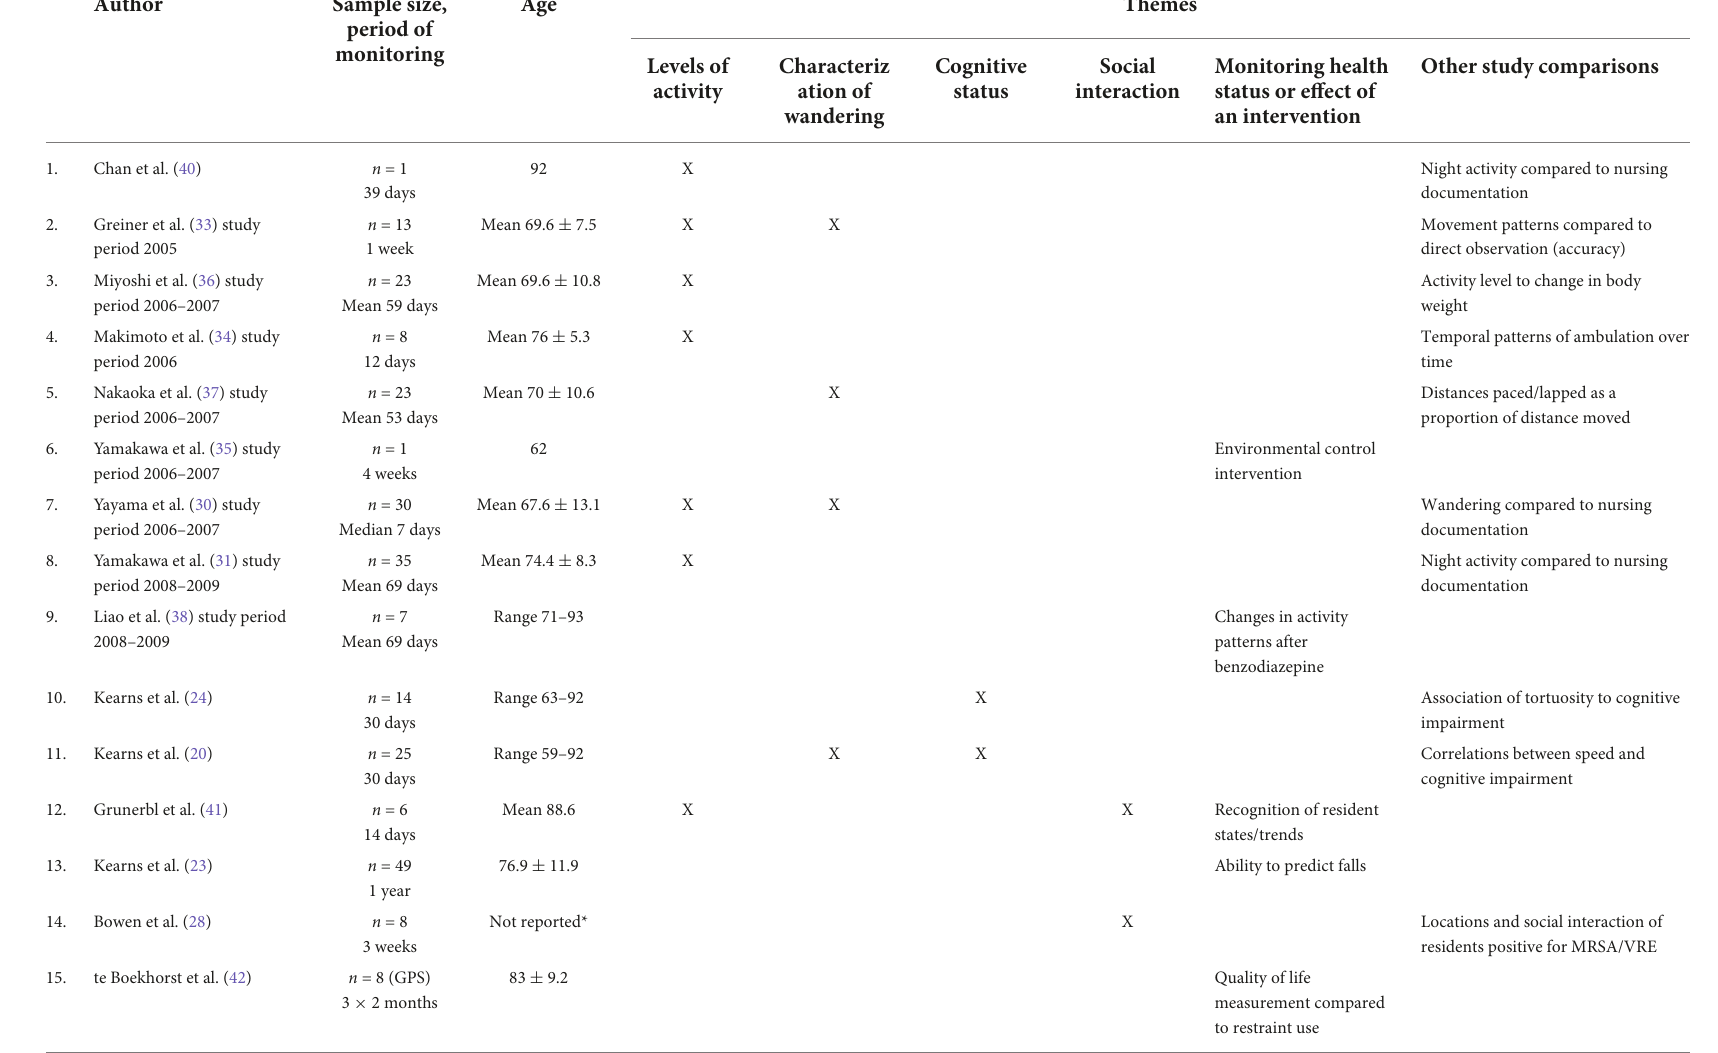
TABLE 3 Themes of RTLS use in older adults with dementia in residential living (by publication